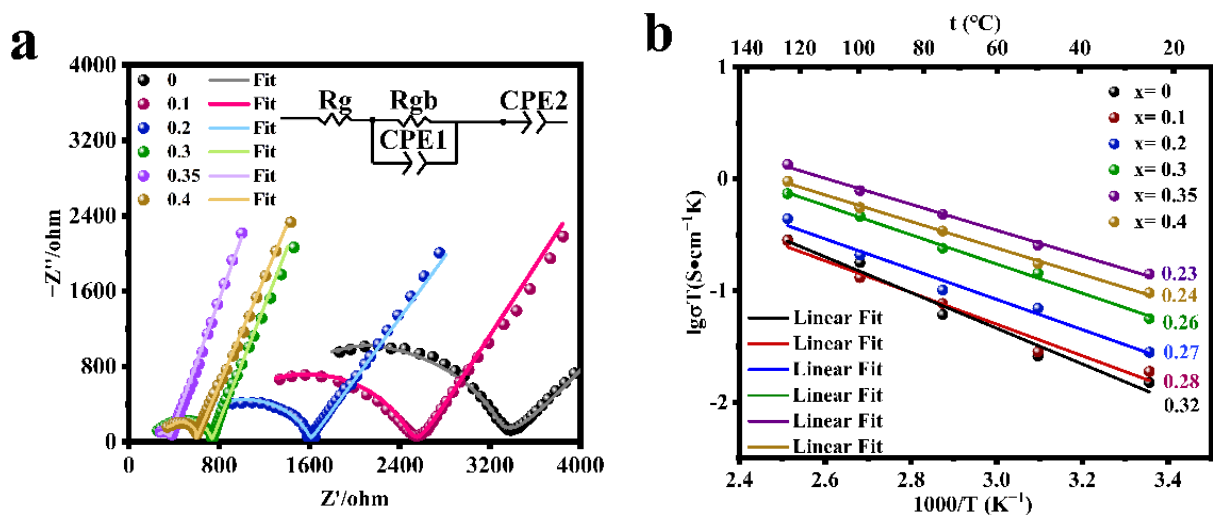
Figure 4. ( a ) EIS curves of LATP-xSn (x = 0–0.4) solid electrolytes at 25 °C and ( b ) the Arrhenius plot of the lithium ionic conductivity of LATP-xSn (x = 0–0.4) solid electrolytes. Table 2. Grain impedance (Rg), grain boundary impedance (Rgb), grain conductivities ( σ g), grain boundary conductivities ( σ gb), total conductivities ( σ t), activation energy (Ea), and relative density of LATP-xSn (x = 0–0.4) solid electrolytes.